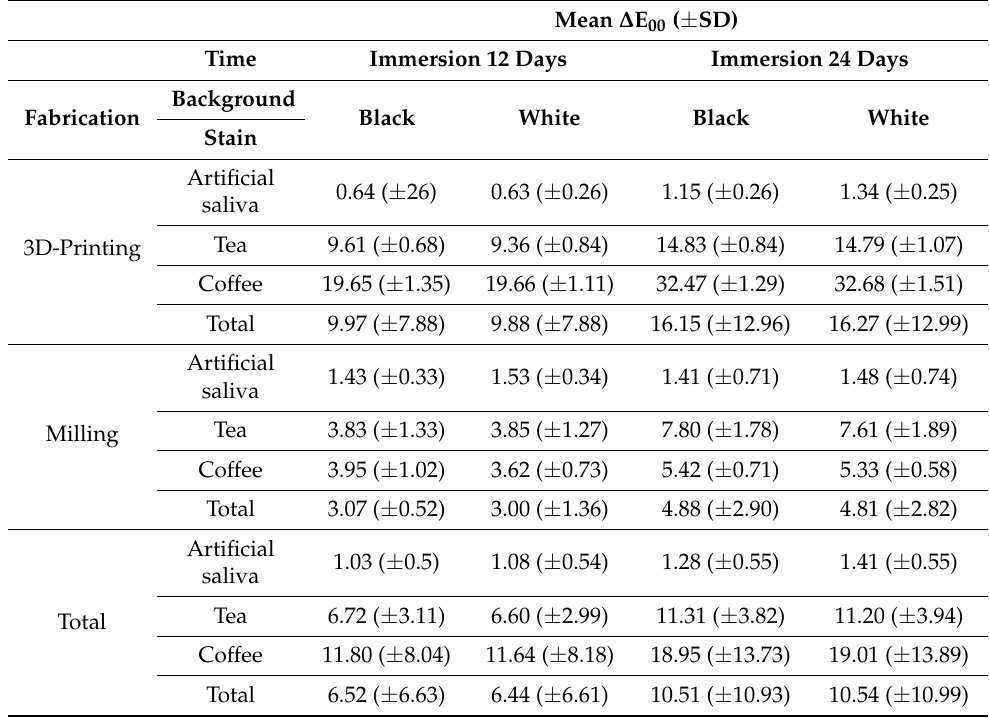
Table 1. Mean (SD) of ∆ E 00 of 3D-printed and milled specimens after immersion in artificial saliva, tea and coffee for 12 and 24